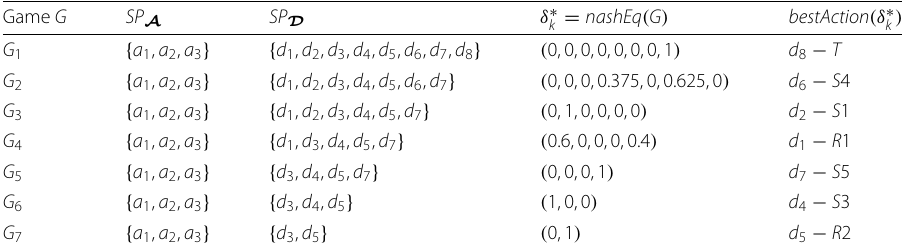
Table 3 A chain of stochastic security games Game